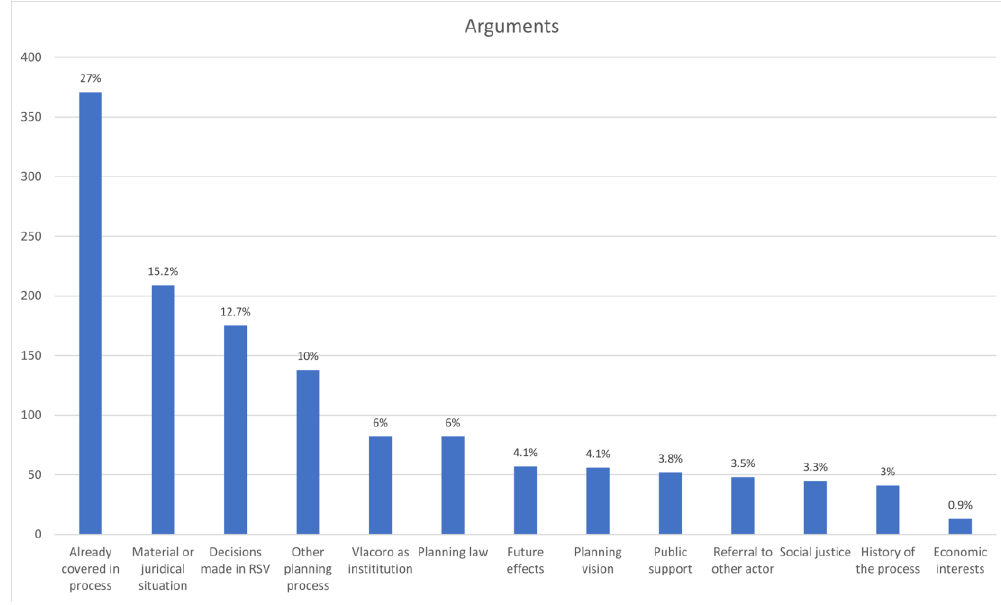
Figure 3. Arguments used in the responses to objections (including internal references).